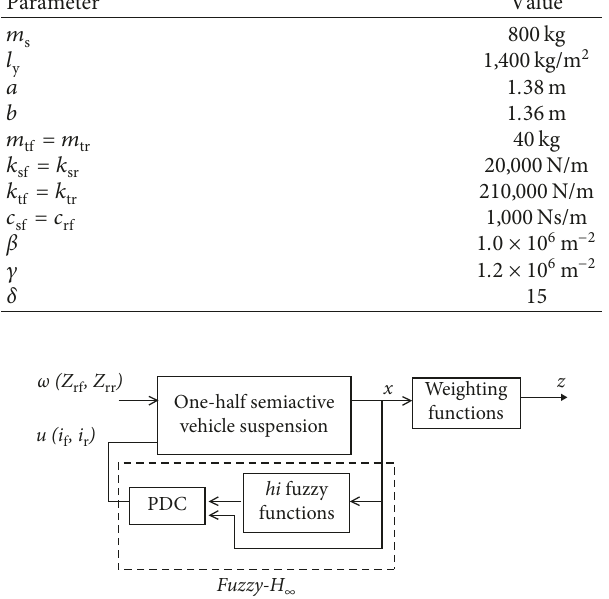
Figure 7: Semiactive suspension with a fuzzy-H